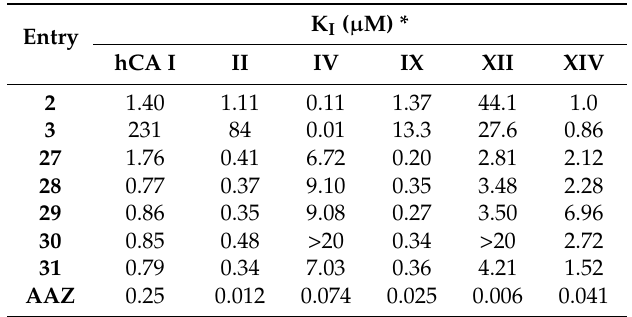
Table 2. Human (h)CA I, II, IV IX and XII inhibition data with polyamines 27 – 31 in comparison with spermidine 2 , spermine 3 and a classical CAI acetazolamide ( AAZ )